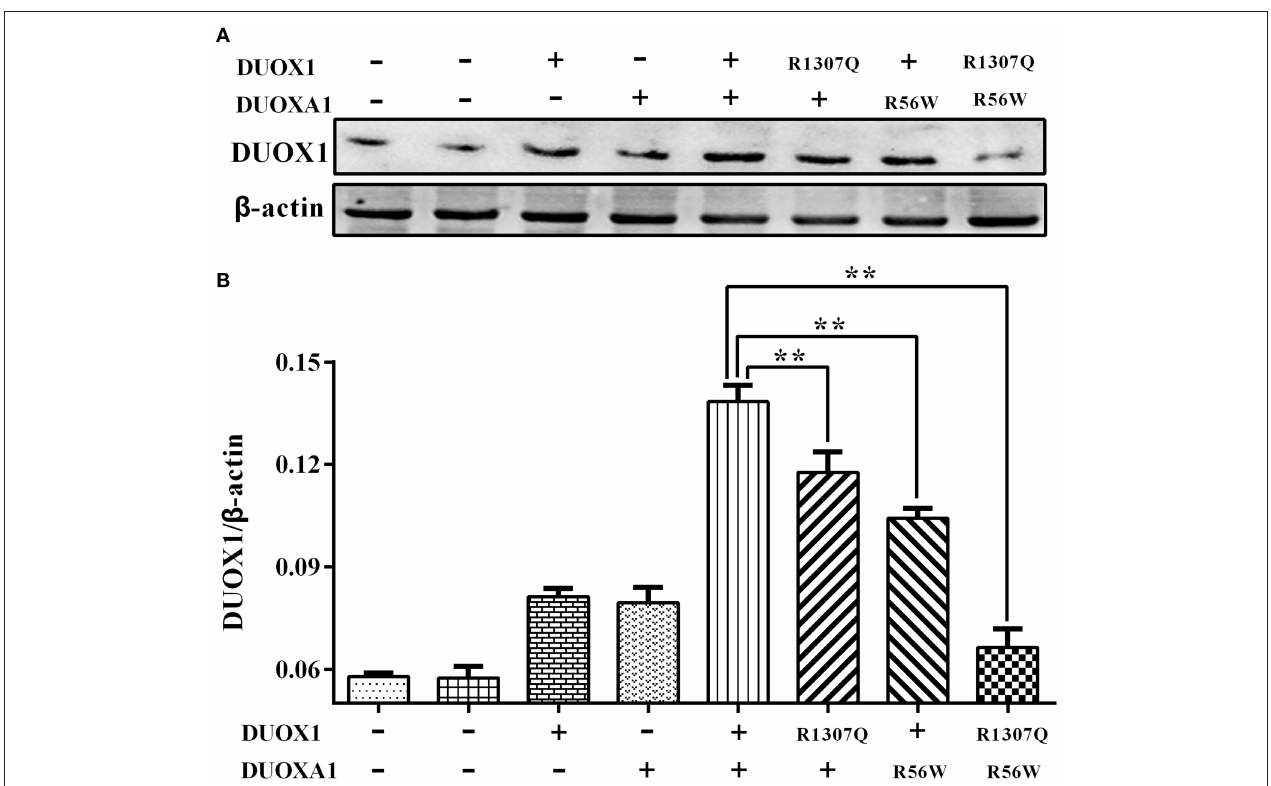
FIGURE 4 | Western blot analysis of the DUOX1 protein expression under various indicated vector transfections. (A) Representative presentation of the gel results. The DUOX1 protein level was highest in the group with both wild-type DUOX1 and DUOXA1 expression vectors, while the group transfected with both p.R1307Q mutant and p.R56W mutant had the least expression level. (B) Densitometric measurement of DUOX1 protein expression. The results are presented as the ratio of DUOX1/ β -actin, corresponding to (A) . Primary antibodies against DUOX1 was used at a 1:250 dilution and Anti-beta-actin, as loading control, was used at a 1:2,000 dilution. Each column represents the mean ± SD of three independent experiments performed in triplicate. ** P <